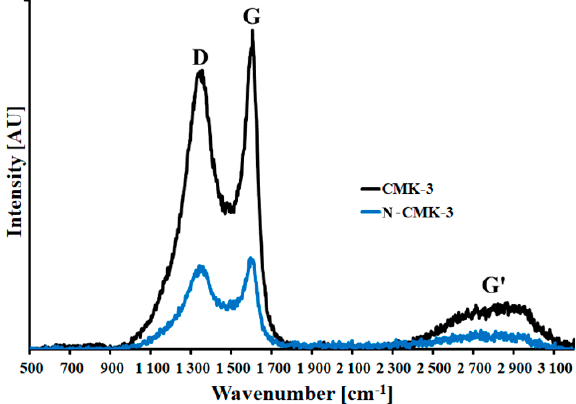
Figure 4. Raman spectra of studied carbon materials.